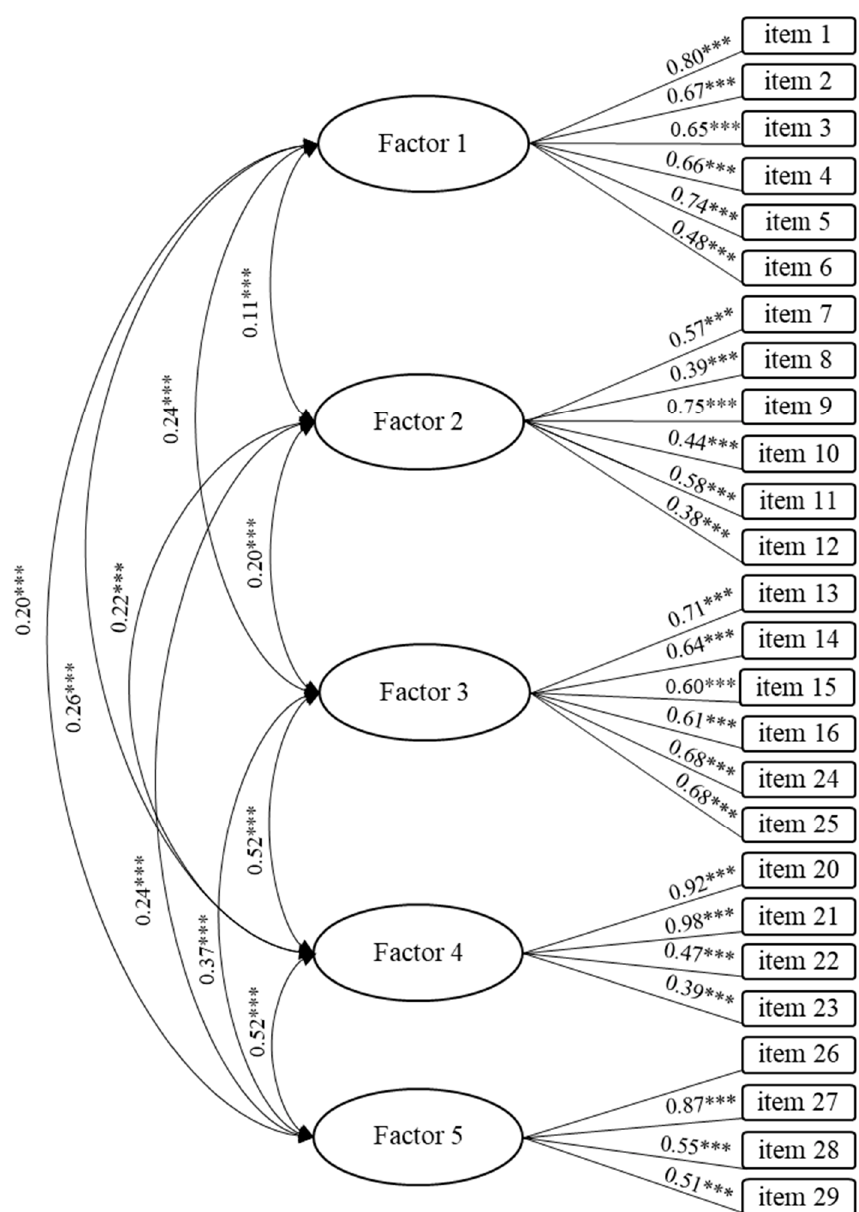
Figure 1. Five-factor model (Model 3 with 26 items). F1 = cooking skills; F2 = emotional management; F3 = healthy consumption as a priority; F4 = nutritional literacy and planning; F5 = availability of ultra-processed foods (*** p < 0.01).